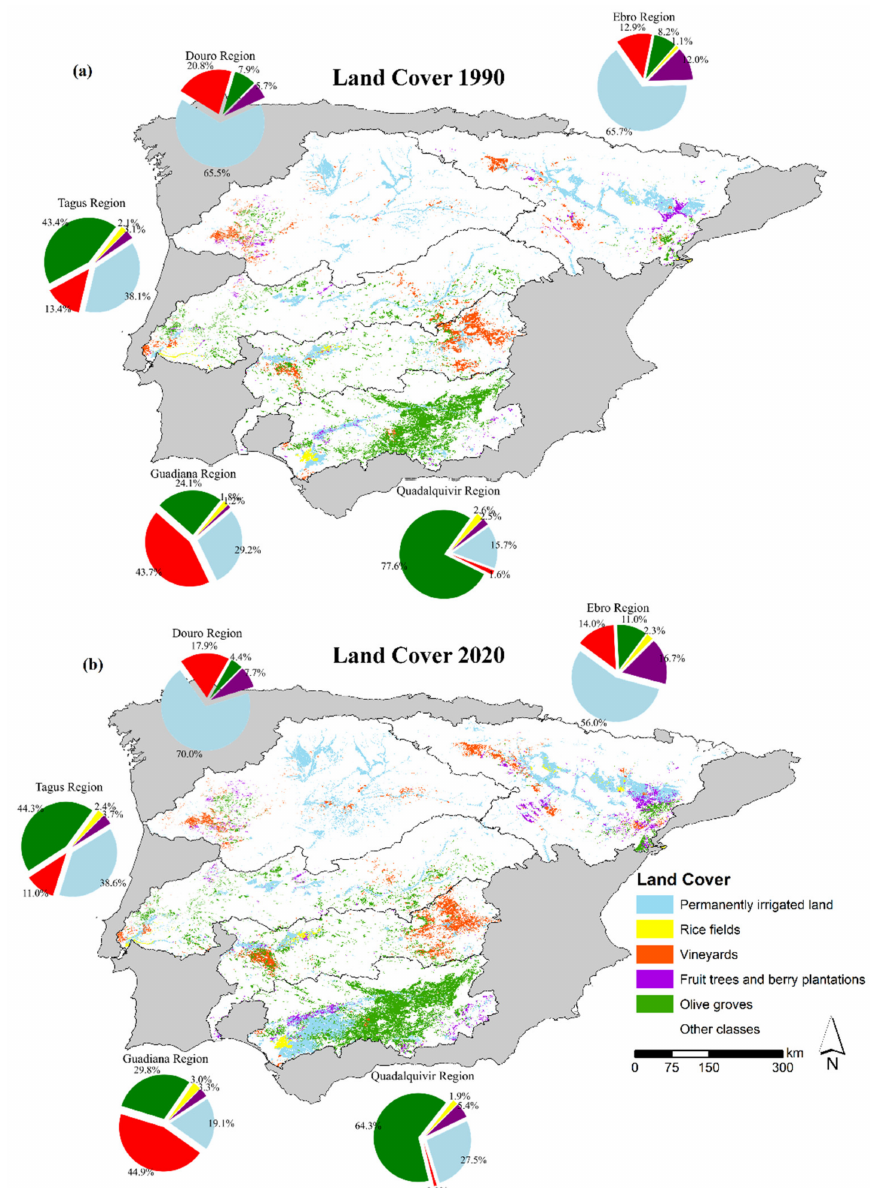
Figure 2. Land cover for water-dependent areas in the Iberian Peninsula, for the years ( a ) 1990 and ( b ) 2020. Pie charts show the percentage of area evolution from one period to